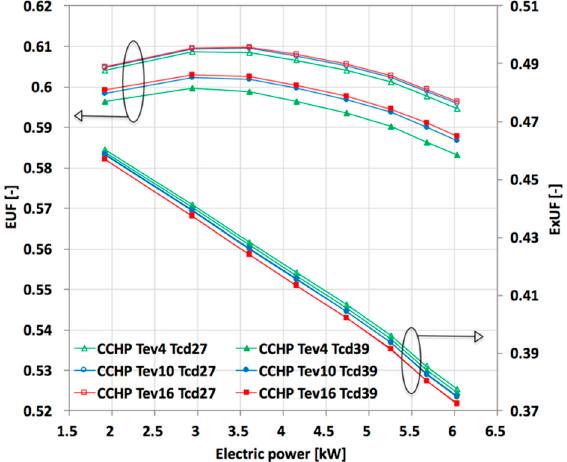
Figure 9. EUF and ExUF vs. electric power for CCHP mode.